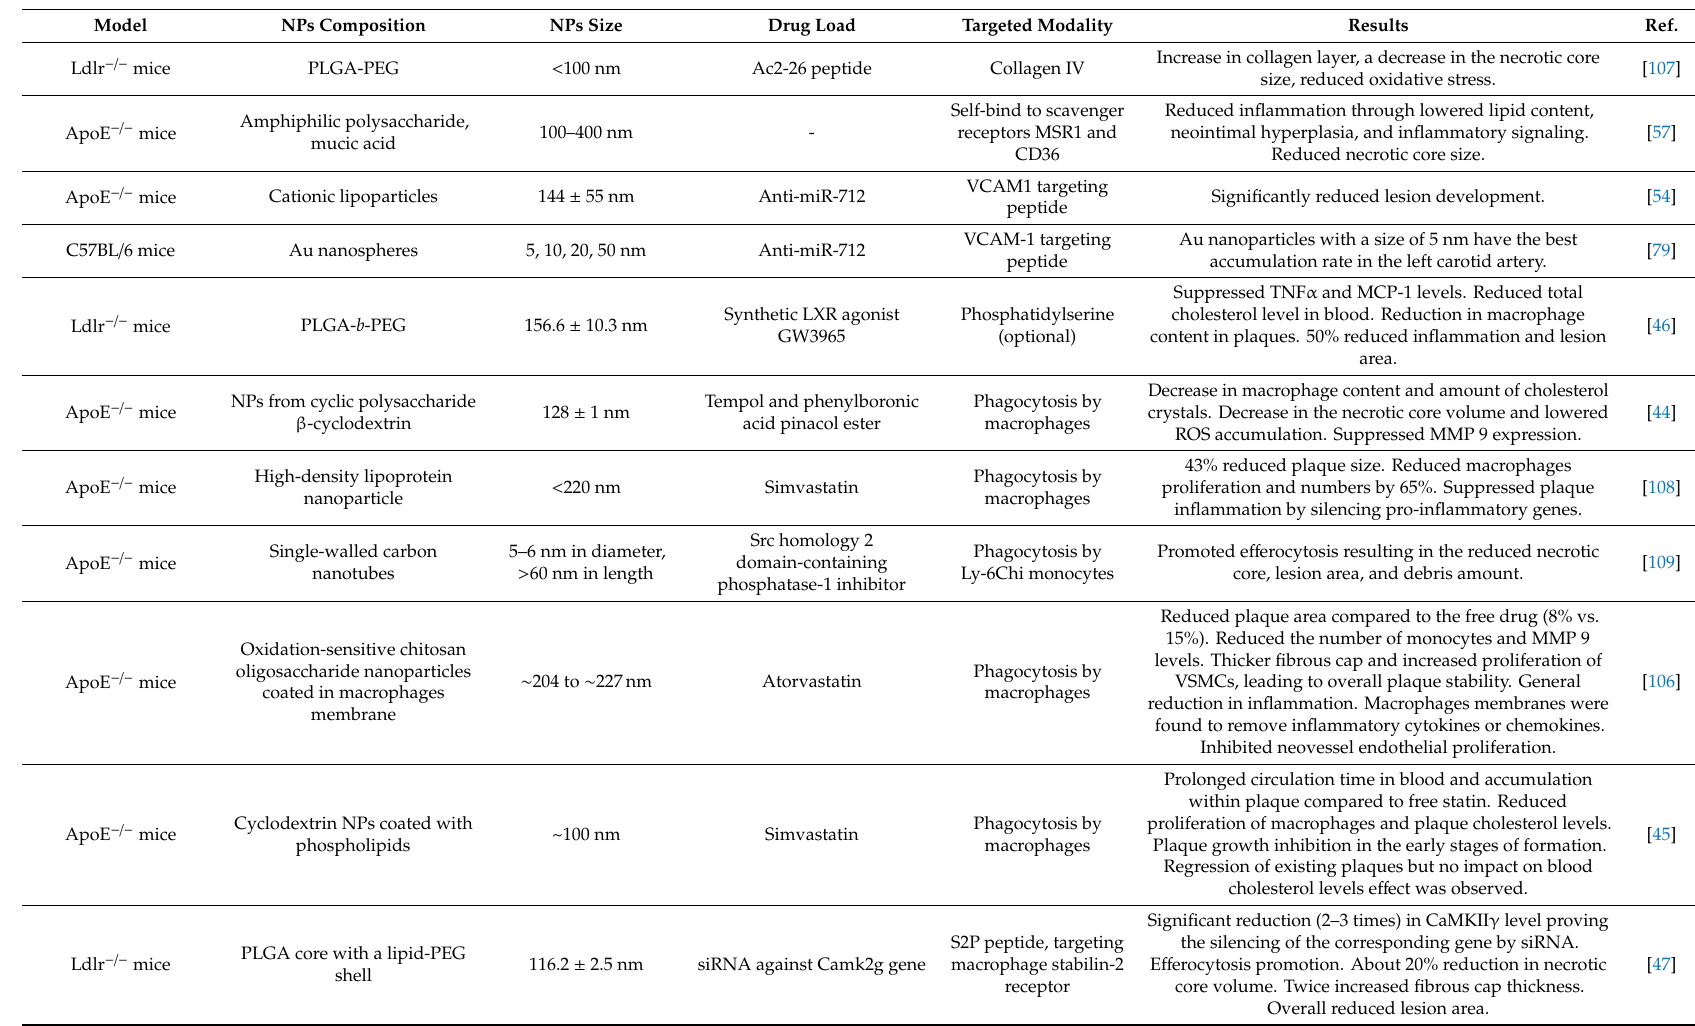
Table 2. Nanoformulation with in vivo proved e ffi